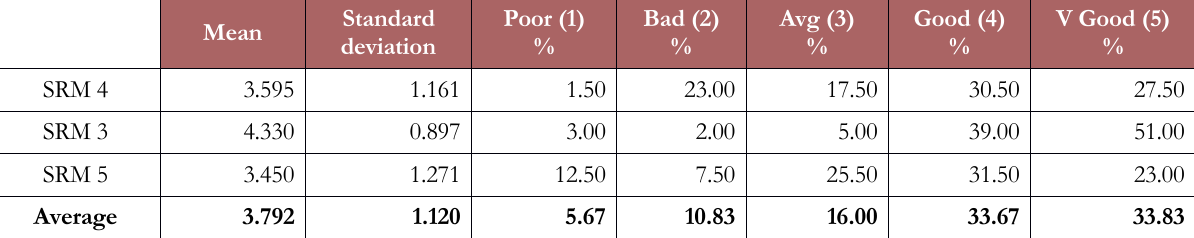
Table 10. Supplier Relationship Management factor